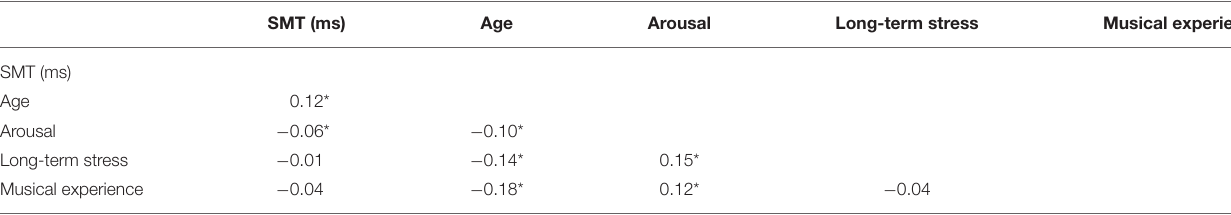
TABLE 2 | Correlation matrix using Spearman’s rho .